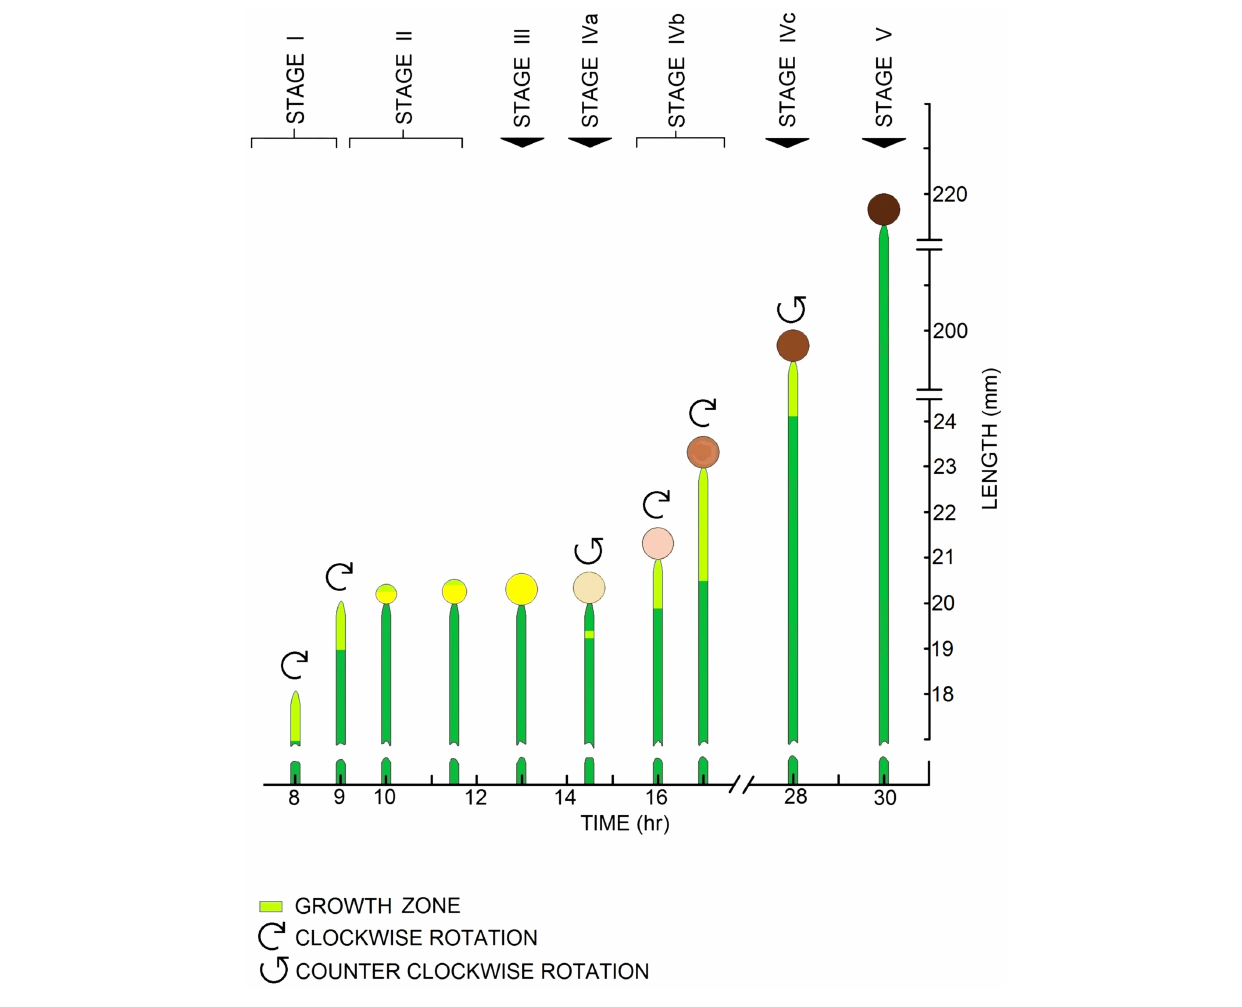
FIGURE 1 |A schematic illustration of the developmental stages of Phycomyces blakesleeanus . Stage I sporangiophore appears as a single pointed tube that grows longitudinally at the apical tip in the growth zone.The growth zone is light green and the non-growing stalk is dark green. Clockwise rotation (when viewed from above) and elongation growth occur concurrently during stage I producing left-handed helical growth. Stage II begins with spherical growth at the apical tip without elongation and rotation growth.The diameter of the sporangium continues to increase until stage III, where the diameter is constant ( ≈ 0.5mm). During stage III there is no visible growth. Stage IVa begins with elongation growth concurrent with counter-clockwise